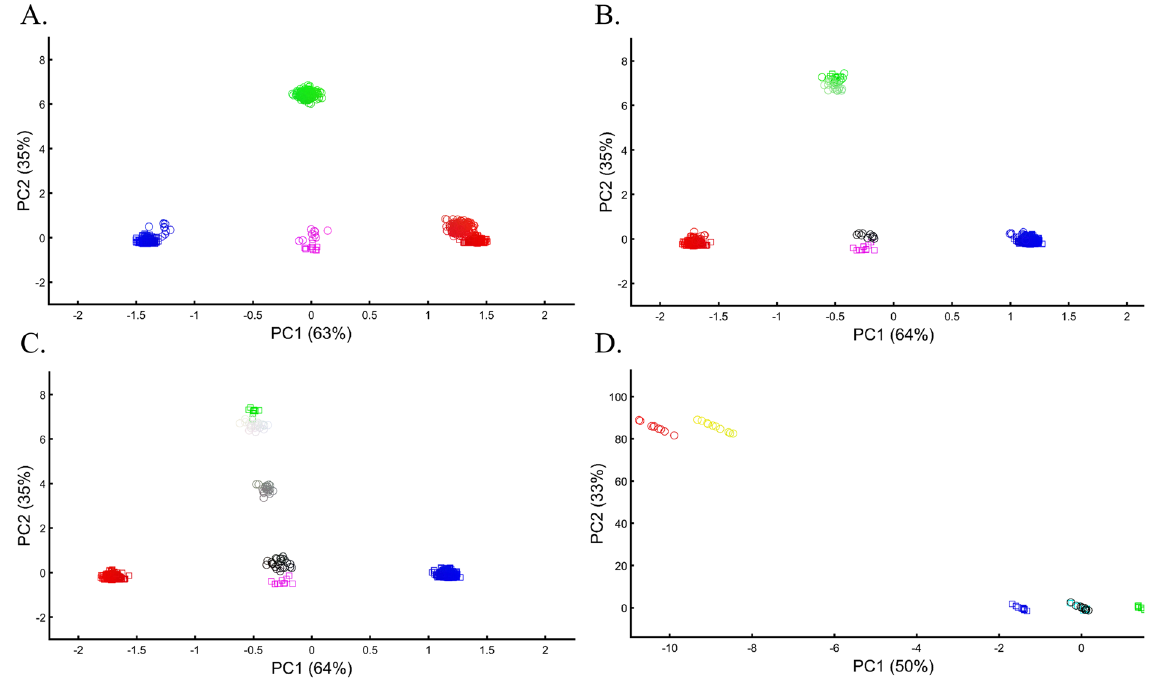
n Blue = 200, n Purple = 10) and second ( n Red = 200, n Green = 200, n Blue = 10, n Purple = 10) datasets, where in the second dataset, colors varied a little (e.g., [1,0,0] → [1,0.1,0.1]). In ( B – D ), the sample size varied (10 ≤ n ≤ 300) for both datasets. Colors include Red [1,0,0], Green [0,1,0], light Green [1,0.2,1], Cyan [0,1,1], Blue [0,0,1], Purple [1,0,1], Yellow [1,1,0], Grey [0.5,0.5,0.5], White [1,1,1], and Black